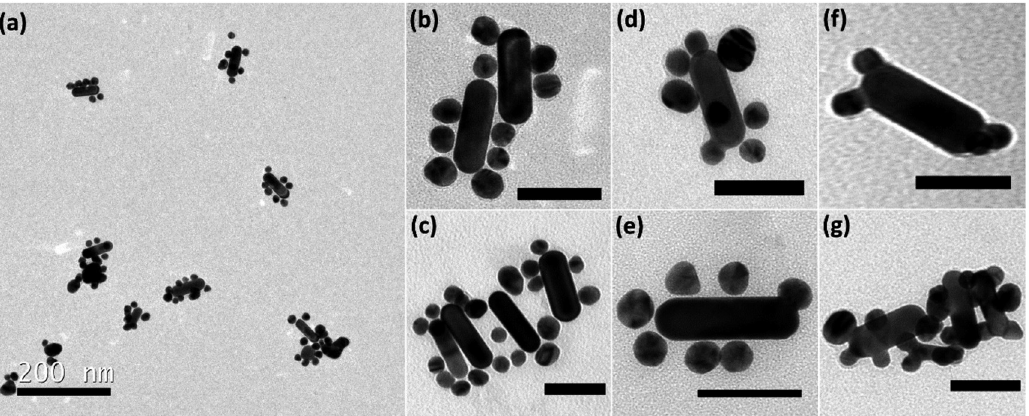
Figure 3: TEM micrographs of typical rod – sphere clusters obtained, (a) low and (b) high magni fi cation images before irradiation and high magni fi cation images after irradiation with laser pulses at a fl uence of (c) 0.5, (d) 1.0, (e) 2.0, (f) 4.0 and (g) 6.0 J/m 2 . The irradiation time in all cases is 12 min. The scale bars represent 200 nm in (a) and 50 nm in all other